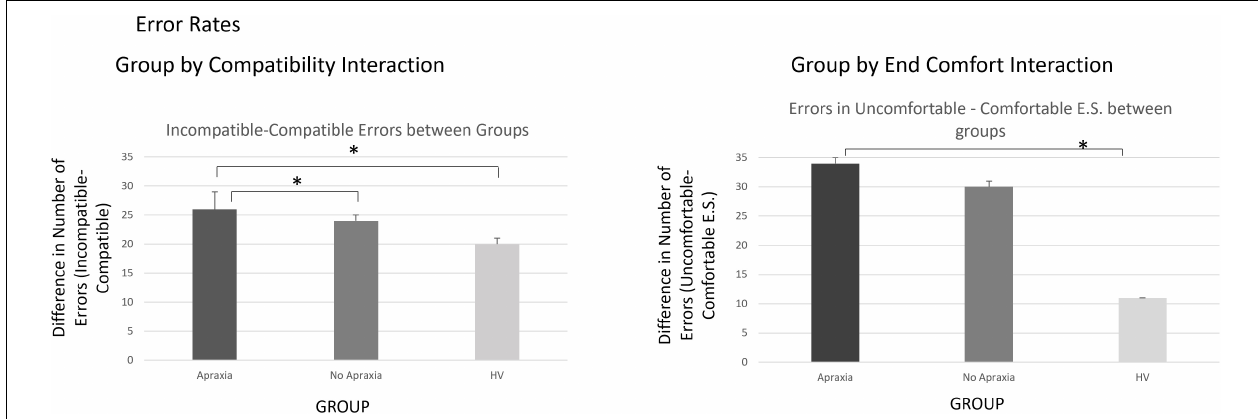
Healthy volunteers (18 participants)